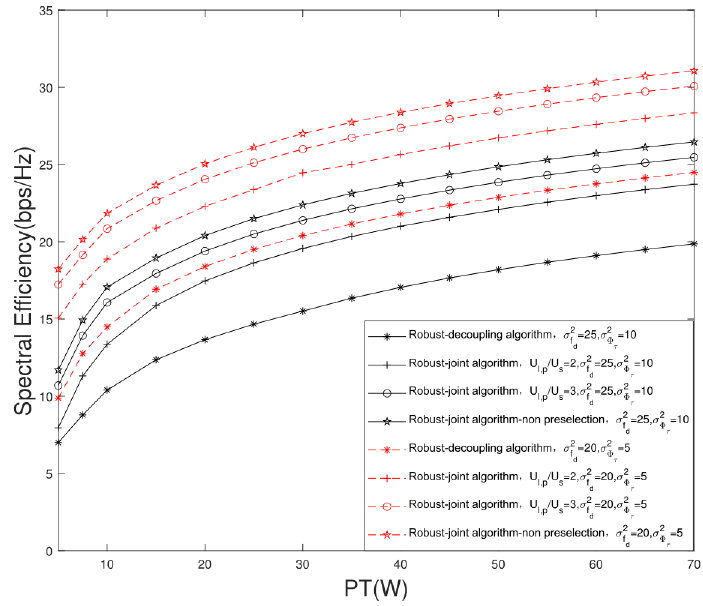
Figure 9. Change trajectory of system SE versus different transmission power thresholds